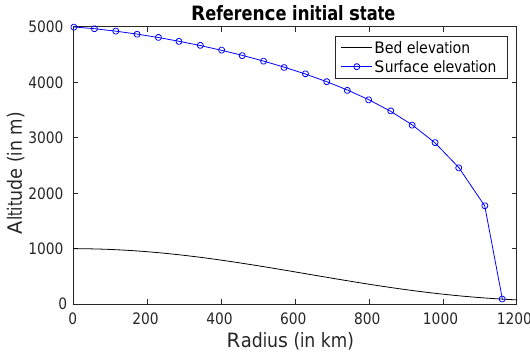
Figure 12. Initial state used to obtain a 20-year reference run under a warming climate as detailed in Sect. 5.1 with n r = 21 grid points and a non-flat